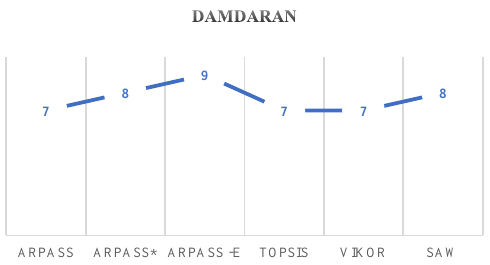
Figure 14. Rank fluctuation of Damdaran in the investigated MCDM methods.